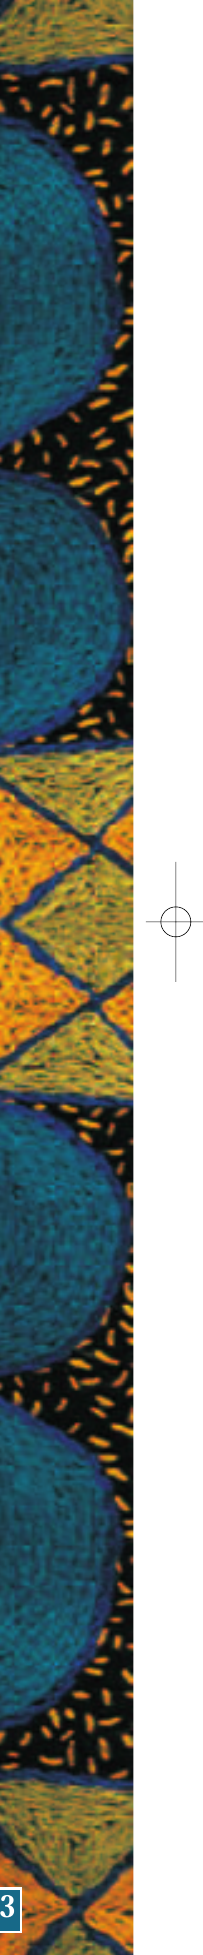
TABLE V. ART DOSAGES IN LIVER